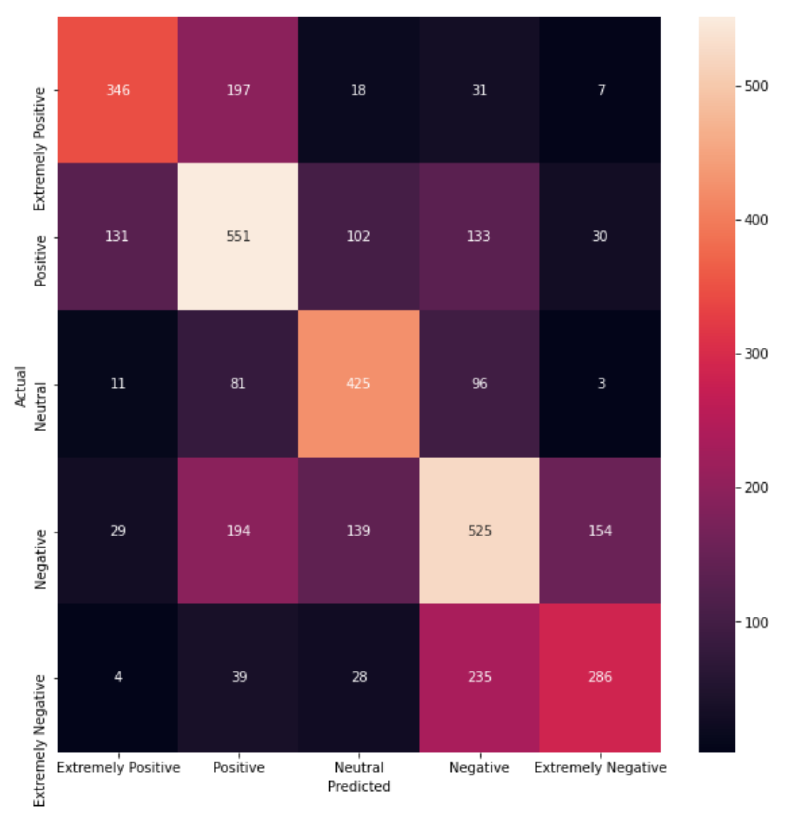
Figure 7. Confusion matrix for the logistic model